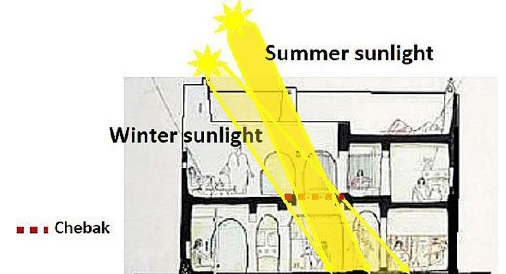
Figure 6. Spatial organisation of a mozabite house (Chabi,